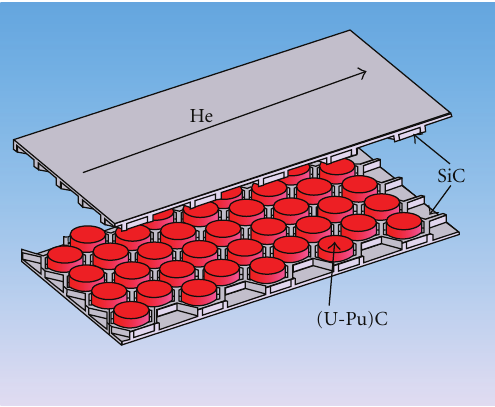
Figure 8: Fuel plate of Gen IV GCFR.